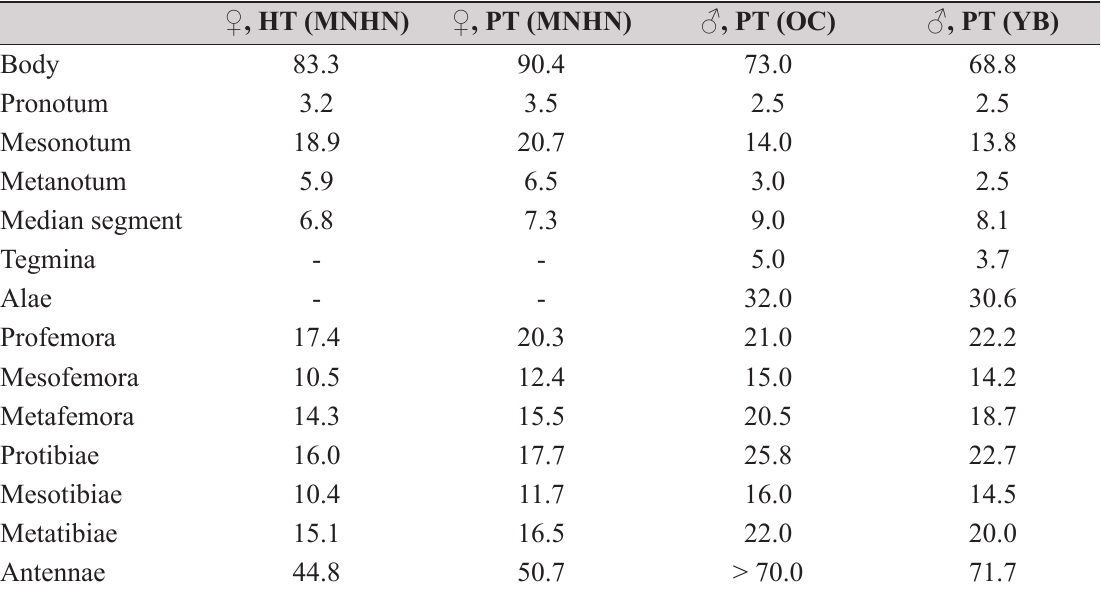
Table 3 . Measurements of Phantasca femorata sp. nov. (in mm). HT = Holotype; PT = Paratype.